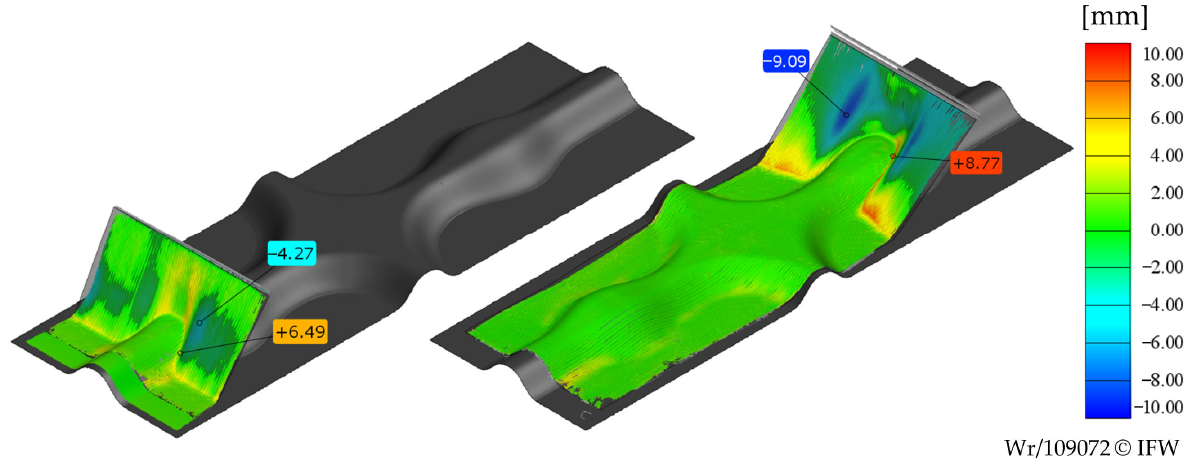
Figure 7. Deviation analysis of draping front formation from experimental surface measurements and simulated data.